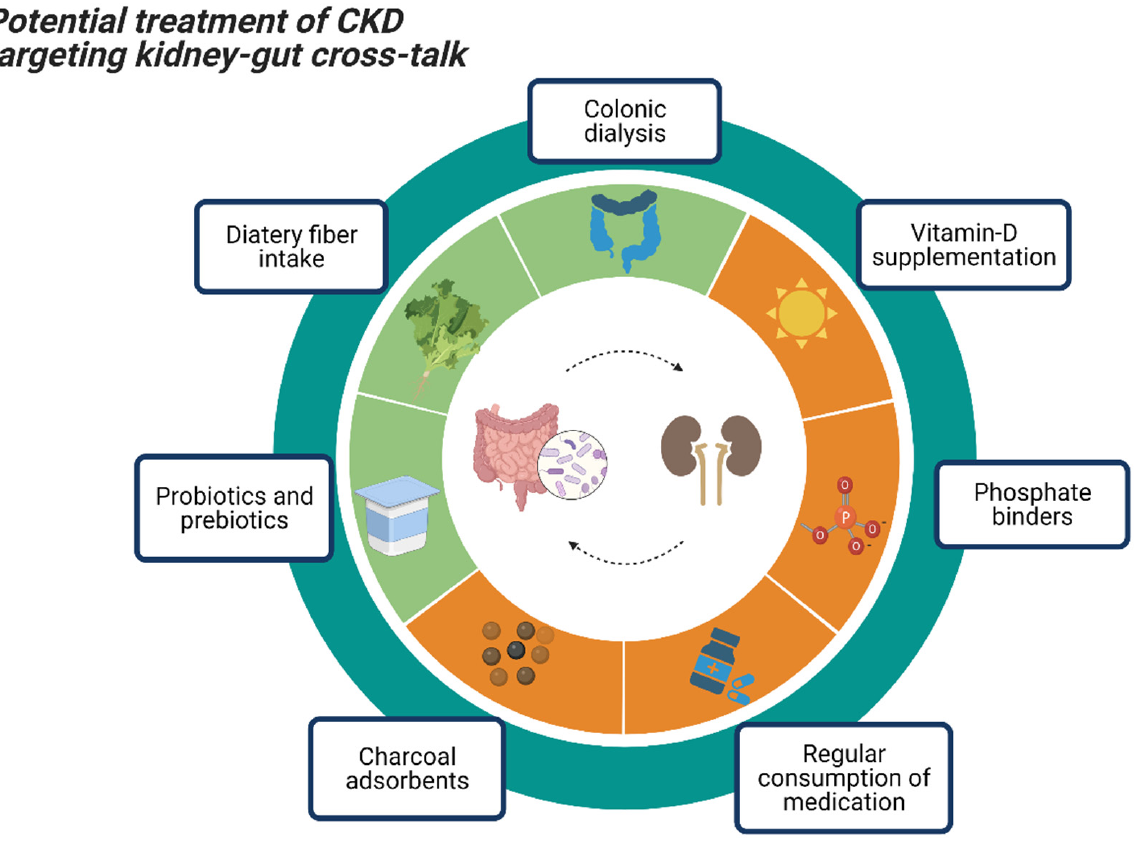
Figure 2. Potential treatment options in CKD patients within the context of a disturbed GI barrier. Treatment considerations are highly dependent on CKD severity. Green indicates promising primary treatment options, whereas orange-marked therapy options require further studies.